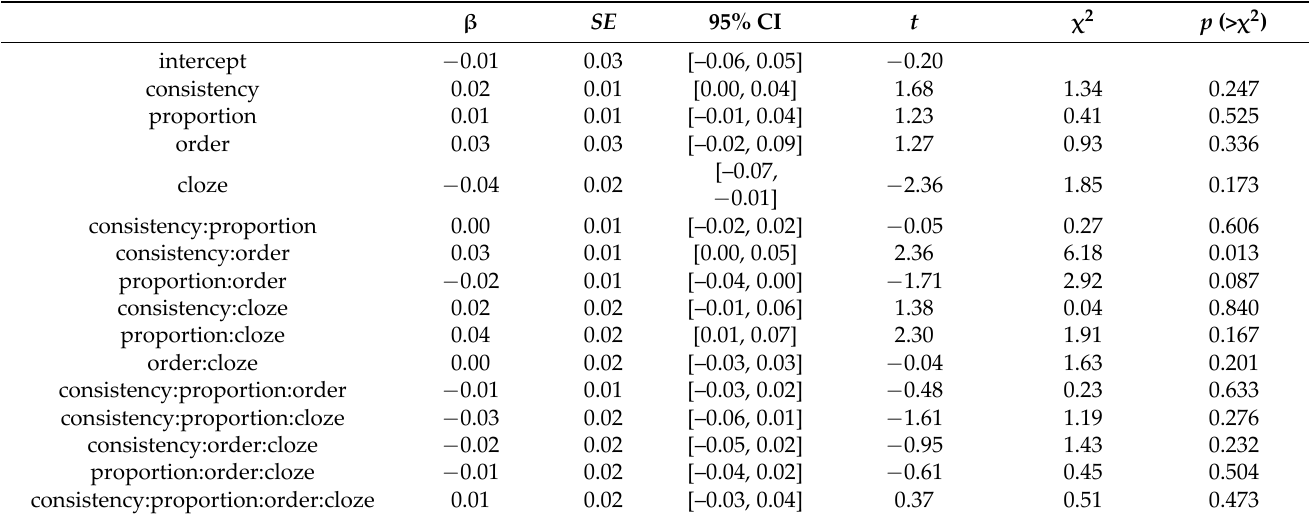
Table 5. Estimates of fixed effects and analysis of deviance (Type II Wald chi‑square tests) for the LN (650–1000 ms) time window.